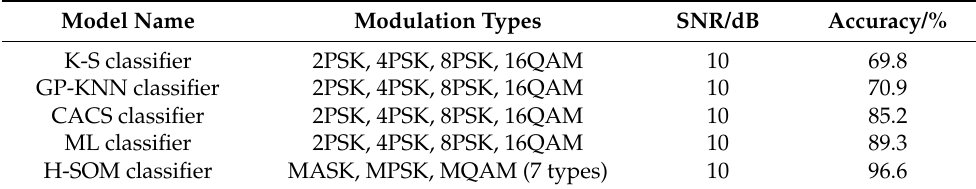
Figure 11. Classification accuracy of the leaf layer for MQAM with discrete transformation under different SNRs. Table 2. The accuracy results among different